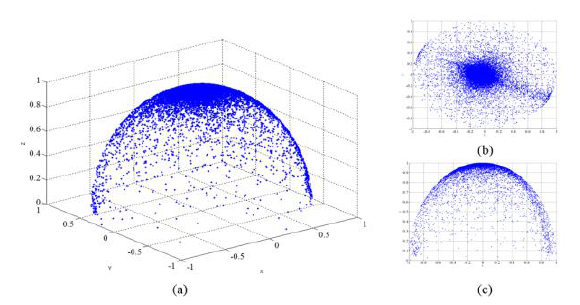
Figure 10: Normal vector direction of all triangles in TIN: (a) Normal vector direction in 3D space; (b) Normal vector direction in X-Y view. (c) Normal vector direction in X-Z view.